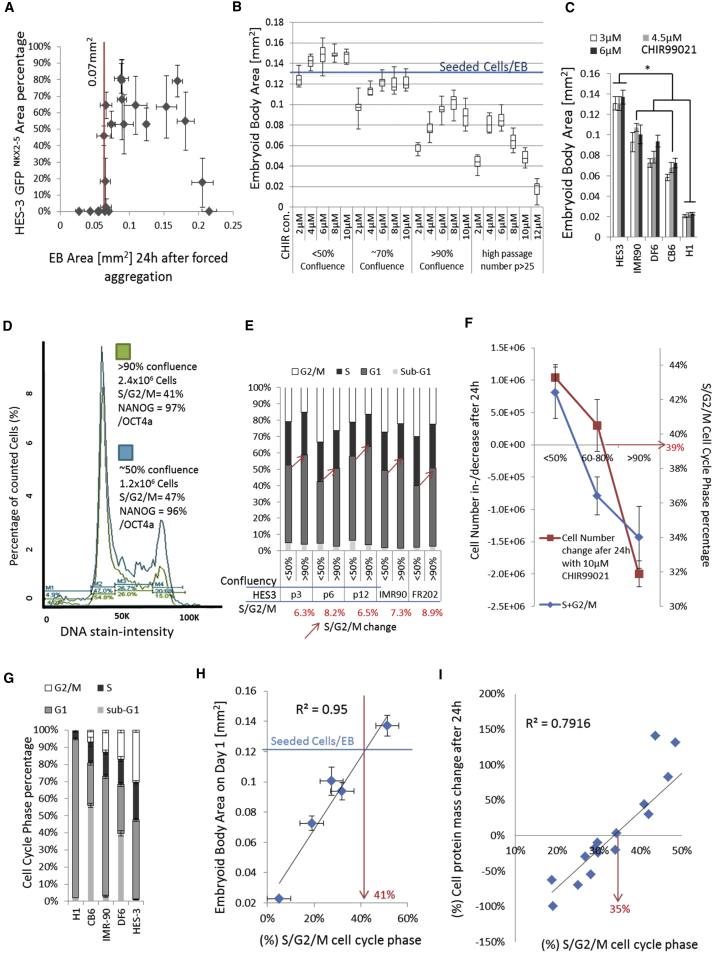
Analysis of the Interaction between Culture Conditions and Cell Cycle in Regard to CHIR Cytotoxicity(A) Correlation between initial EB area size on day 1 and percentage of the GFP area obtained after 10 days of differentiation (induction for 24 hr with 6 μM CHIR) (n = 4).(B) EB area size of 1-day-old forced aggregated EBs (12,500 cells/EB) generated from passage 10 (50%, 70%, and 90% culture confluency) and passage 25 (80% culture confluency) cell cultures (n = 16).(C) EB area size of 5 cell lines after 24 hr CHIR treatment (n = 10, ∗p ≤ 0.05).(D) Cell cycle, pluripotency, and cell count measurements of HES3 cells cultured at 50% and 90% culture density.(E) Cell-cycle profiles of IMR90, FR202, and HES3 passages 3, 6, and 12 cultured at 50% and 90% culture densities; average change of S/G2/M cell-cycle profile in hPSCs between 50% and 90% cell culture confluency was 7.4% ± 1.1% (n = 5).(F) Cell number change after treatment with CHIR and S/G2/M cell-cycle percentage differences of HES3 cells cultured at high (>90%), mid (60%–80%), and low (<50%) culture densities (n = 3).(G–I) Cell-cycle profiles of 5 hPSC lines (G) and their correlation between the percentage of S/G2/M cell-cycle phase (n = 3) and the measured EB area on day 1 after 24 hr CHIR induction (n = 8) (H). Correlation between percentage of S/G2/M cell-cycle phase of 17 hPSC lines and cell culture passages in monolayer cell culture and their change in cell protein mass (%) after 24 hr CHIR induction (I).